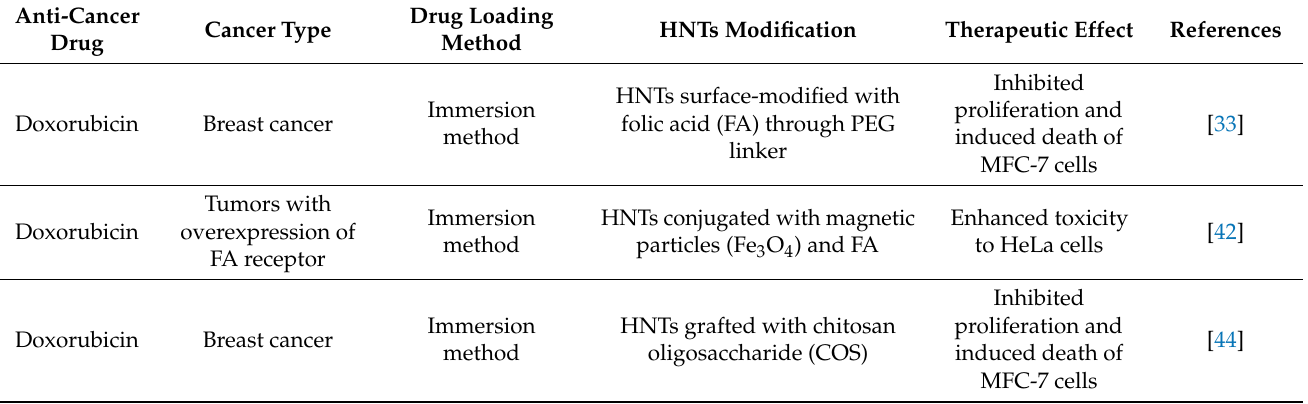
Table 1. A summary of the literature reports on anticancer drugs entrapped in